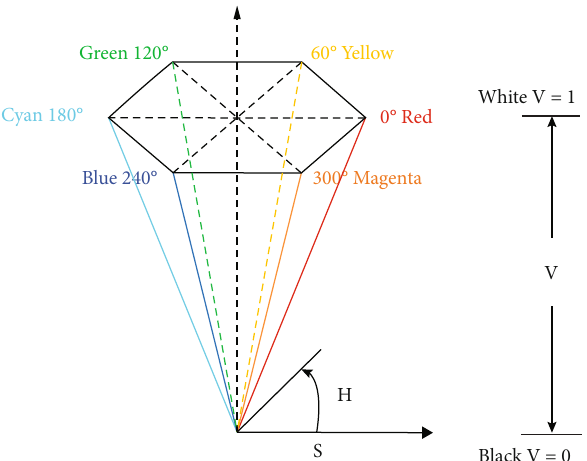
Figure 4: Hue, saturation, and value color space model structure